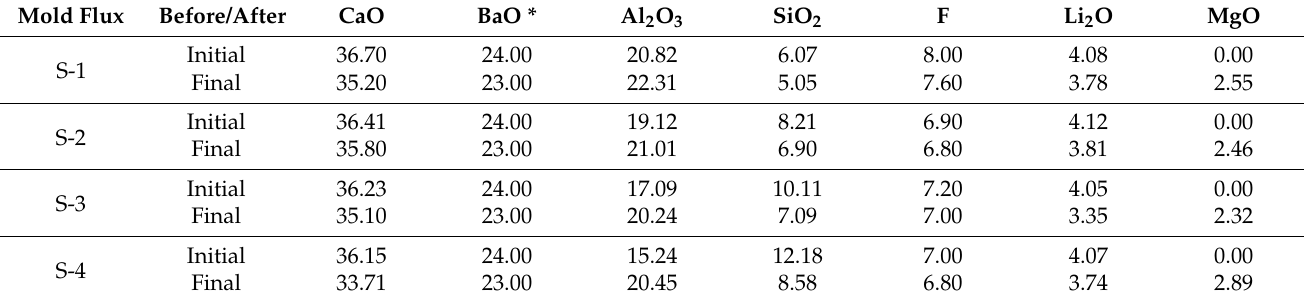
Table 5. Composition of mold flux before and after steel–slag reaction (wt%).